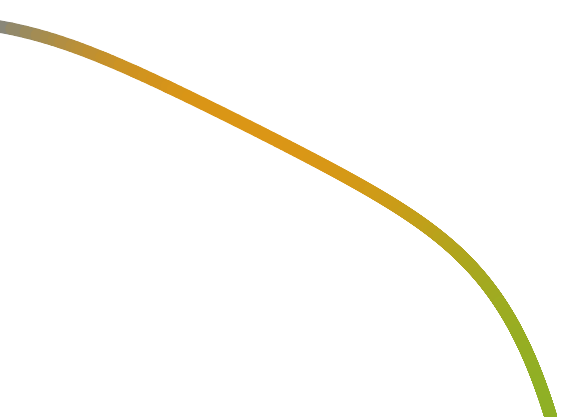
Figure 3. The fitted probability distribution for the tree size data in Figure 1B. This distribution has the same natural metric as in Figure 2C, but with different parameters. The curve is colored to show the change in the scaling of the natural metric with increasing magnitude as linear (blue), logarithmic (gold), and linear (green).